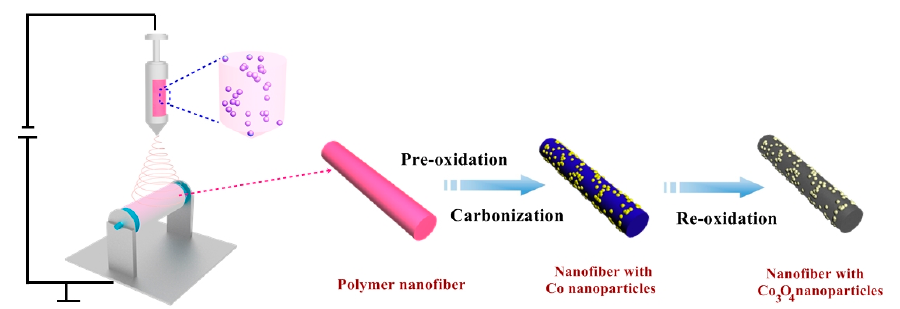
Figure 1. Schematic diagram for the fabrication of Co 3 O 4 @NMCF composite.